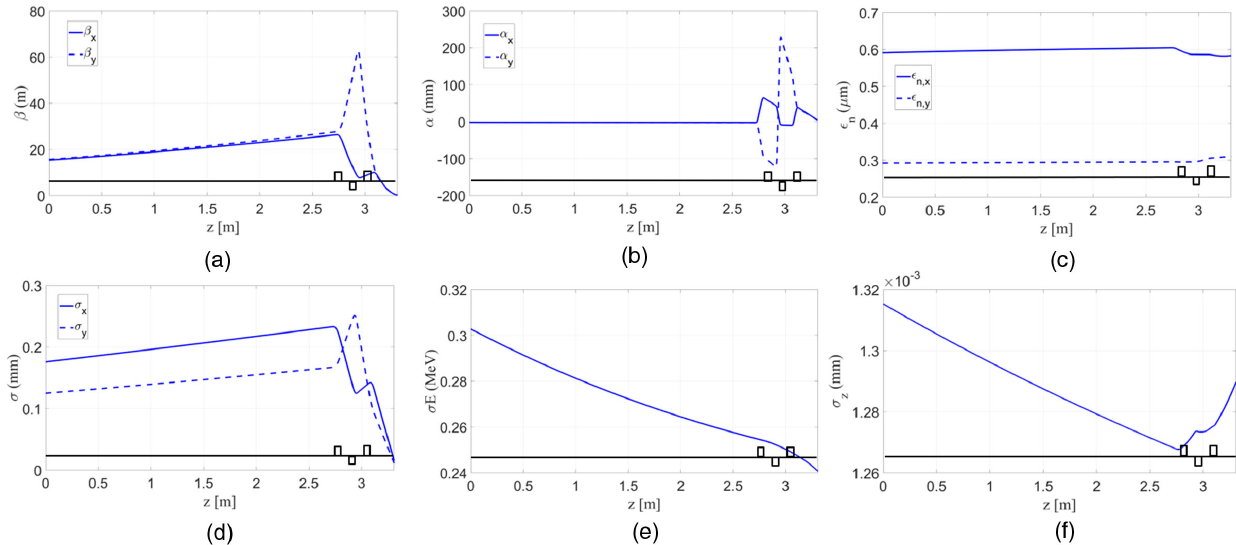
FIG. 5. Evolution of the electron beam parameters, simulated in ASTRA , along the beam line from the exit of the BC until the entrance of the plasma cell. The origin here is set at the exit of the last magnet of the BC. The parameters shown are the Twiss parameters in (a) β and in (b) α , in (c) the normalized transverse emittance ε x;y x;y σ and in (f) the bunch length σ E z